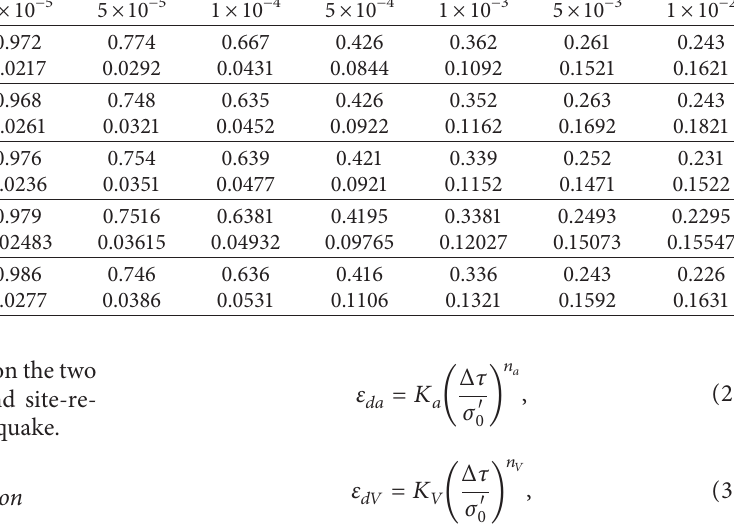
max ) and damping ( λ ) at different shear strains (